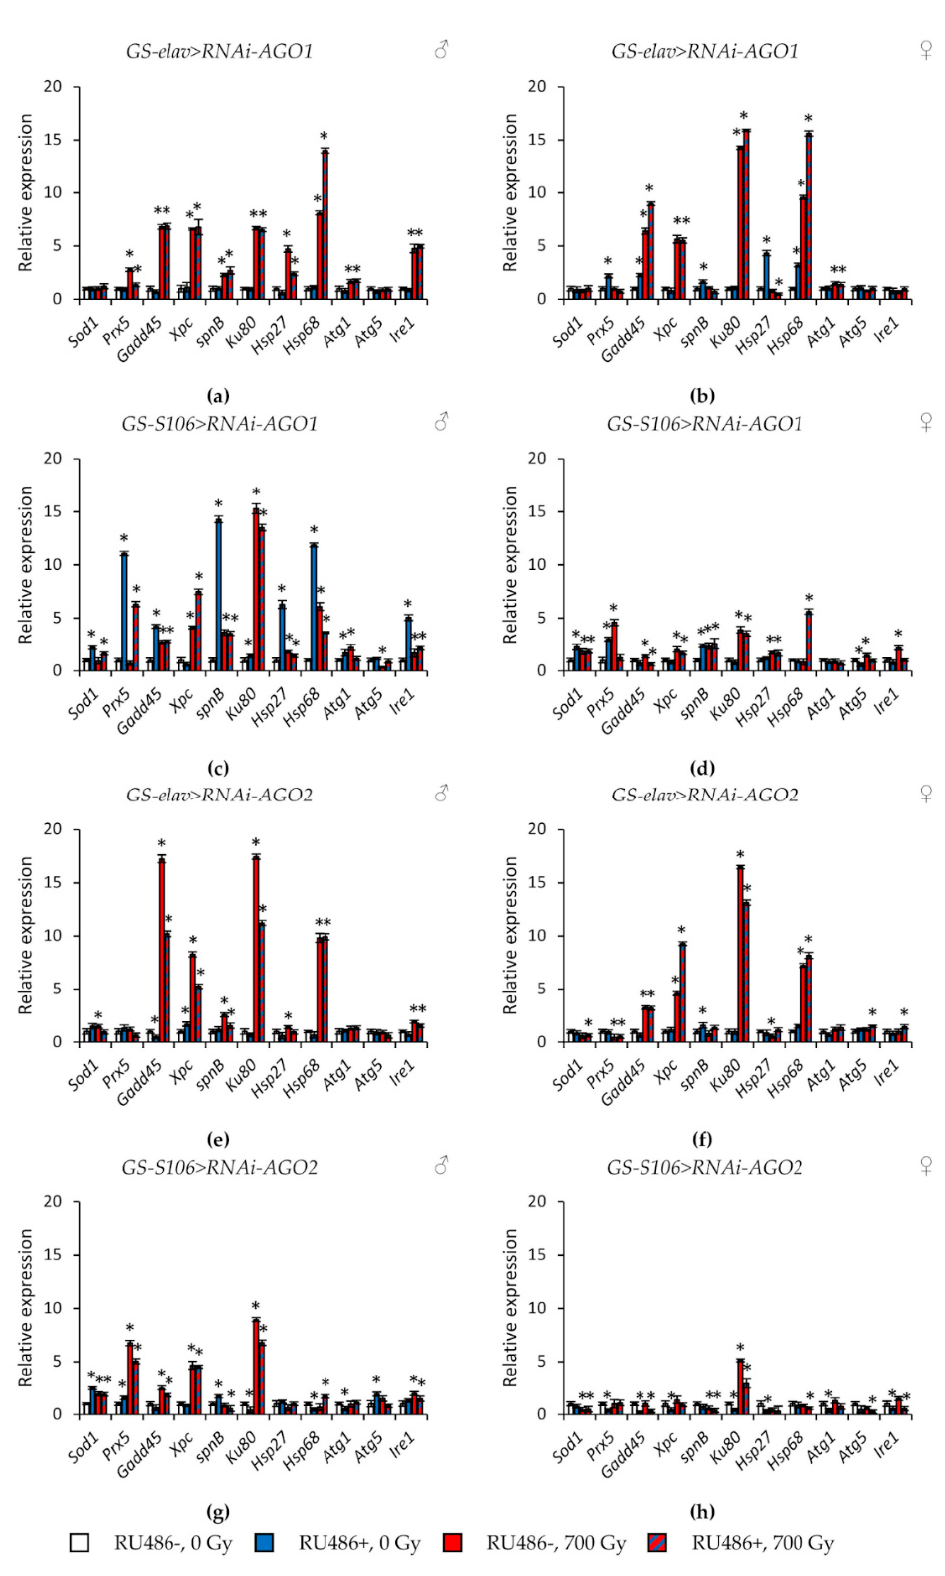
Figure 7. Changes in the expression of stress response genes in irradiated and unirradiated males ( a , c , e , g ) and females ( b , d , f , h ) with AGO1 ( a–d ) and AGO2 ( e–h ) knockdown. Differences between relative expression levels of the investigated genes of unirradiated flies without Argonaute genes’ knockdown (RU486-, 0Gy) and each of other experimental variants are statistically significant with * p < 0.05 (Mann-Whitney U-test).